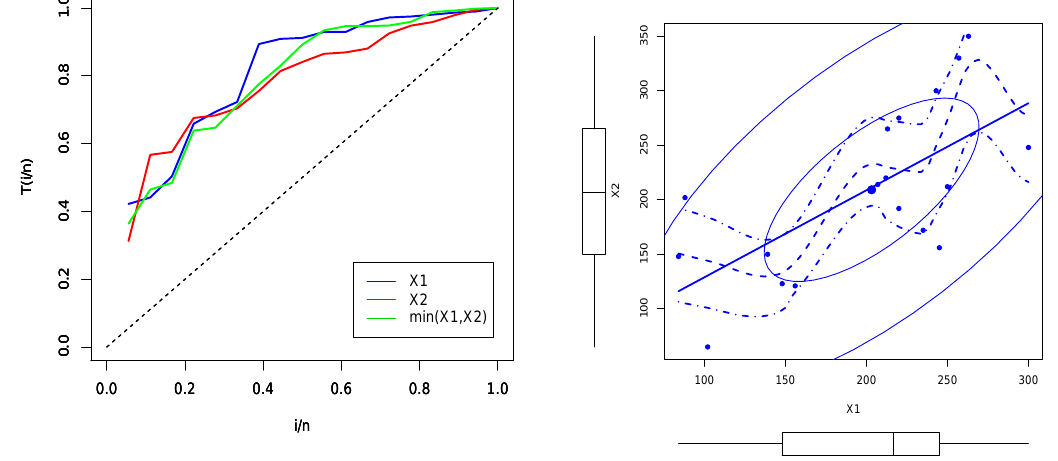
) for data set II. , X and min ( X , X 2 2 1 1